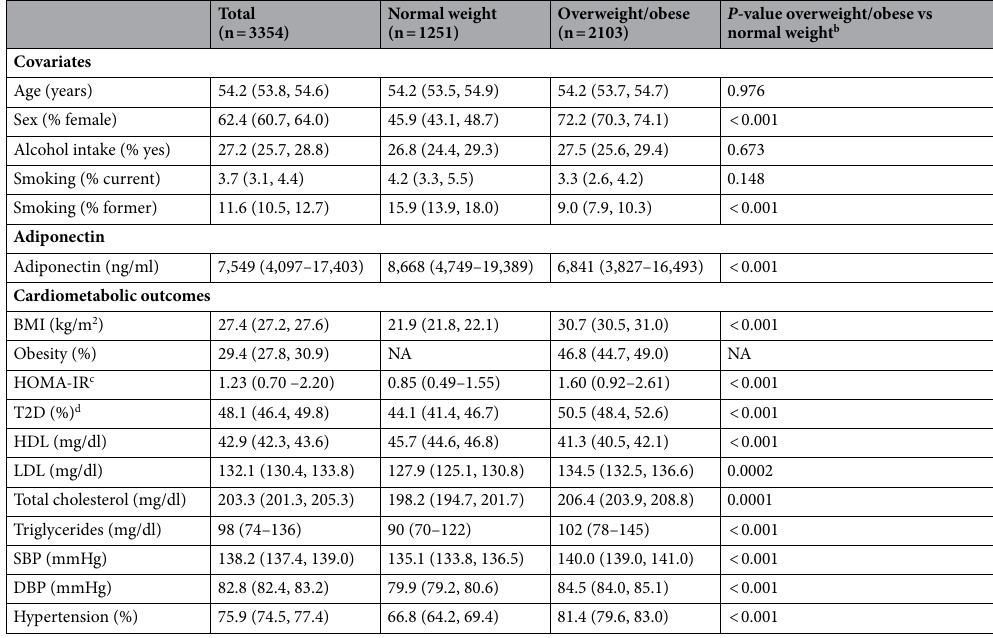
Table 1. Characteristics of the study population a . BMI Body Mass Index, T2D Type 2 Diabetes, SBP Systolic Blood Pressure, DBP Diastolic Blood Pressure. a Continuous variables are in means and corresponding (95% Confidence Intervals) for normally distributed variables. Non-normally distributed variables are expressed in medians and (25th–75th percentile). Categorical variables are in percentages with corresponding (95% Confidence Intervals). b P-values were calculated using T-tests for differences in means, Mann–Whitney U tests for differences in medians, and chi square for differences in proportions. c T2D cases were excluded for all HOMA-IR analyses. d The high T2D prevalence is due to the T2D case–control study design of the